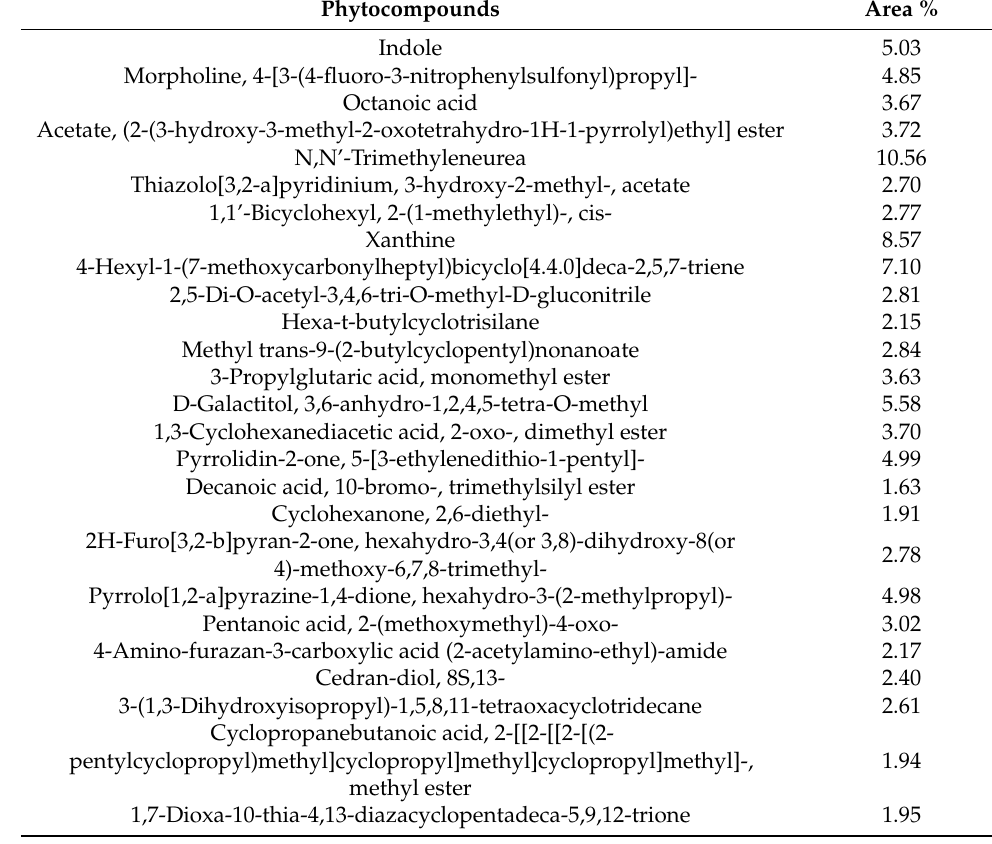
Table 1. Phytochemical compounds of the leaf extract as revealed by GC-MS.